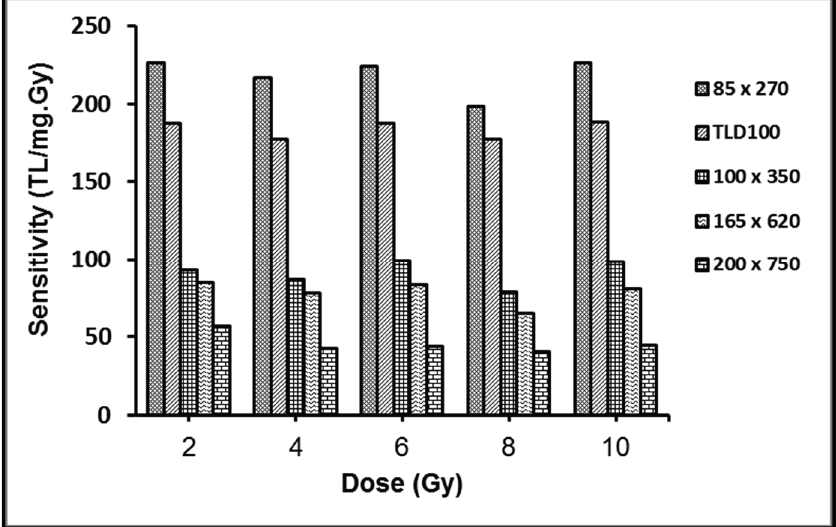
Figure 6. Sensitivities of the different dimension flat fibers and